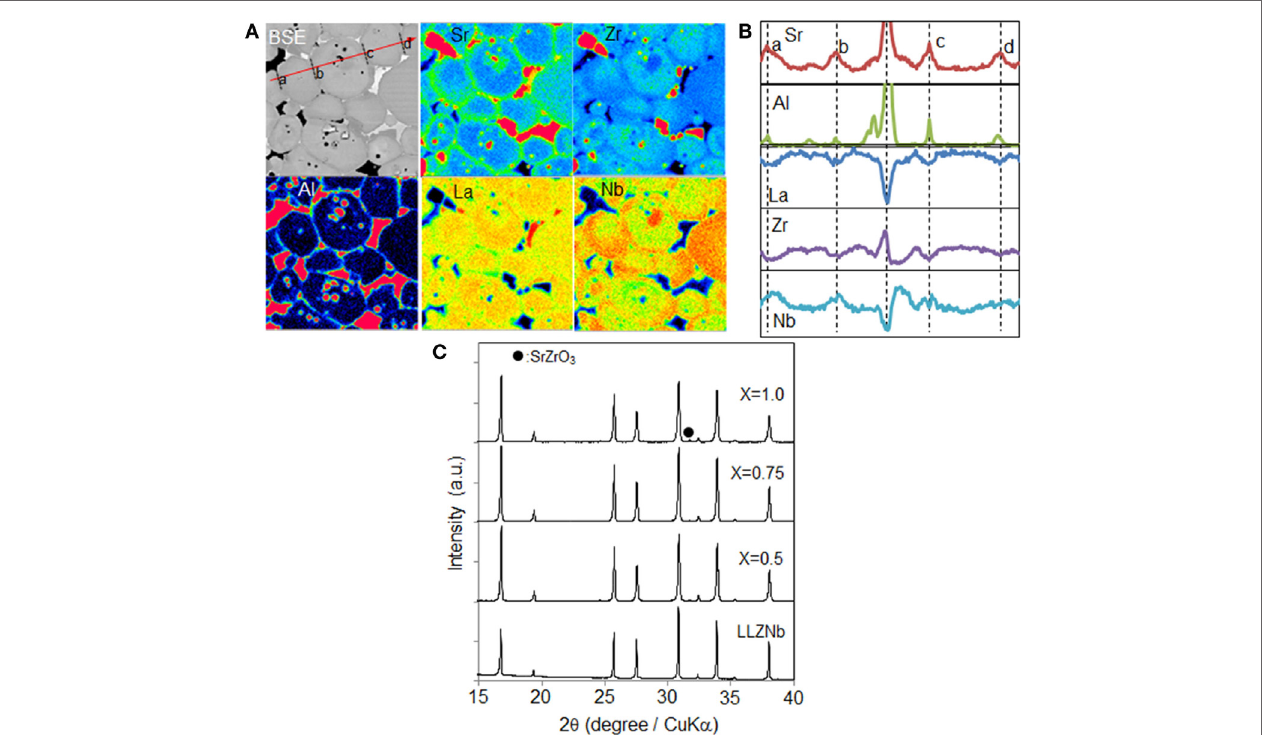
FigUre 3 | (a) Cross-sectional EPMA mapping images of Sr-LLZNb, (B) linear analysis of Sr, Al, La, Zr, and Nb, and (c) XRD pattern obtained from